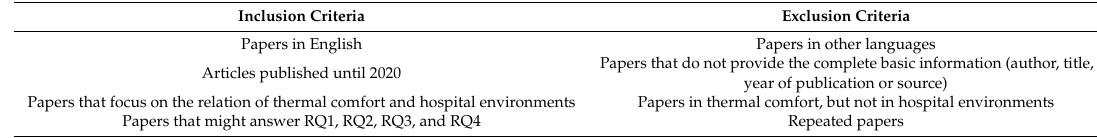
Table 1. Inclusion and exclusion